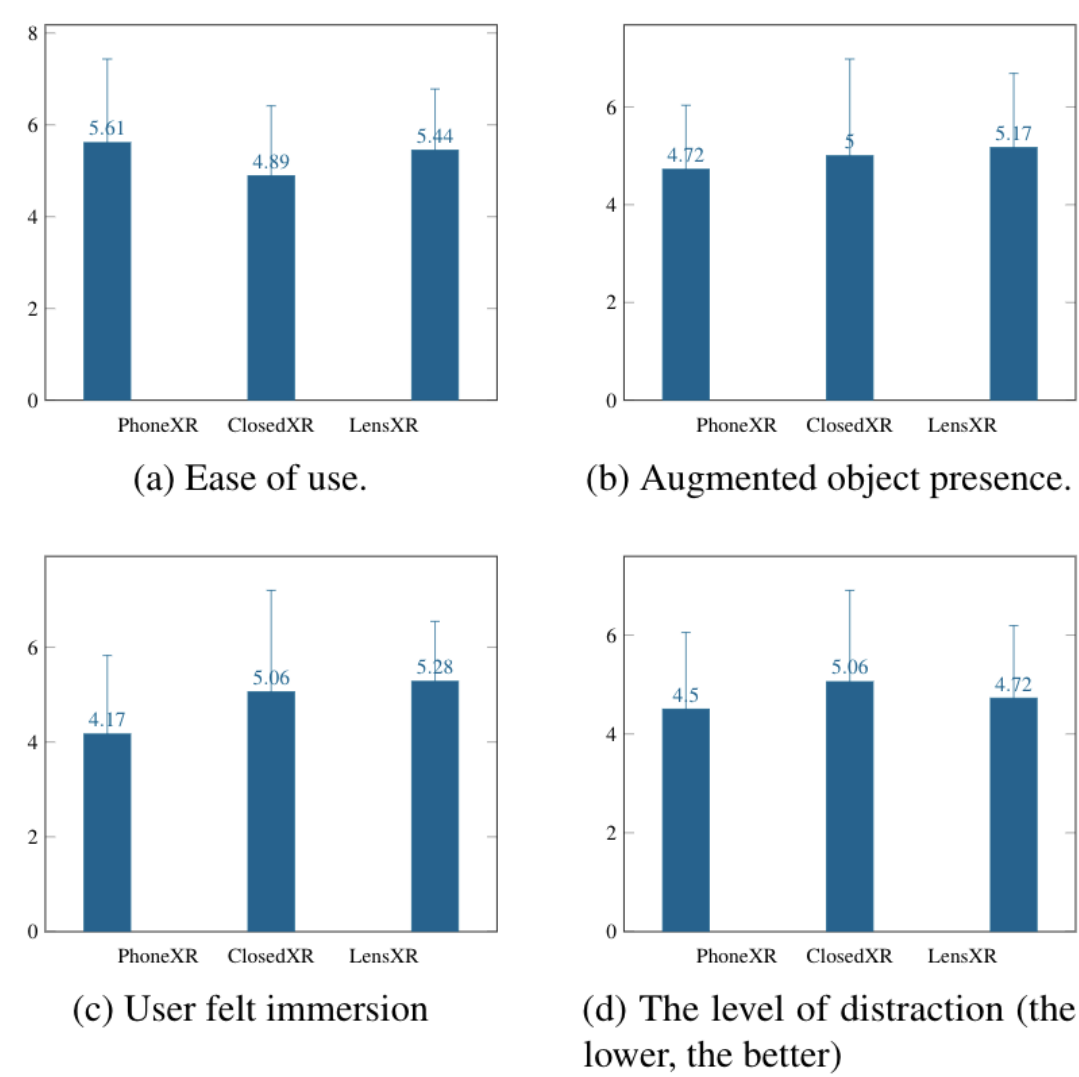
Figure 13. Survey results regarding the UX for AR application. The vertical axes represent the subjective levels in the 7-point Likert